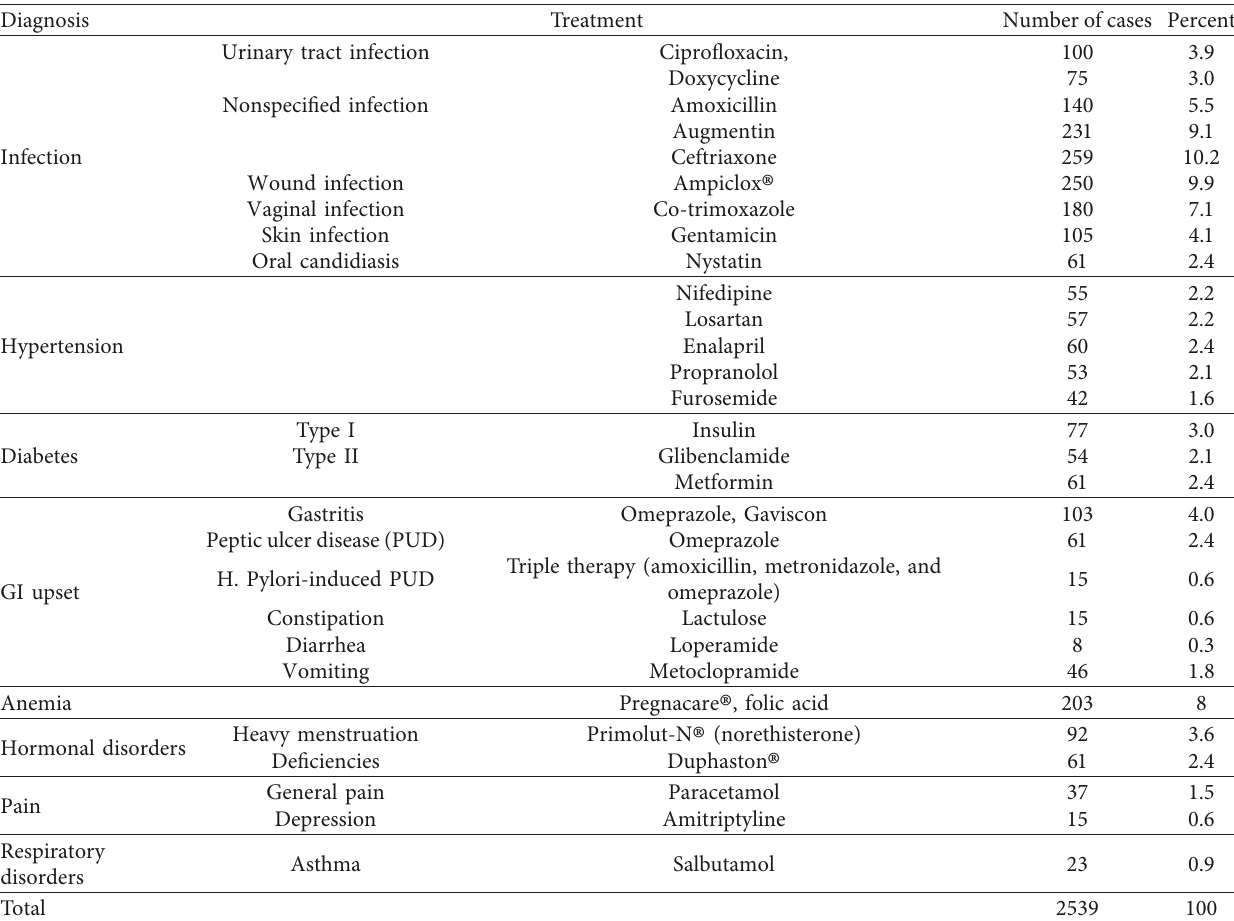
Table 4: Description of the most common cases diagnosed and drugs prescribed at the Edna Adan University Hospital, between August 28, 2019, and August 27,